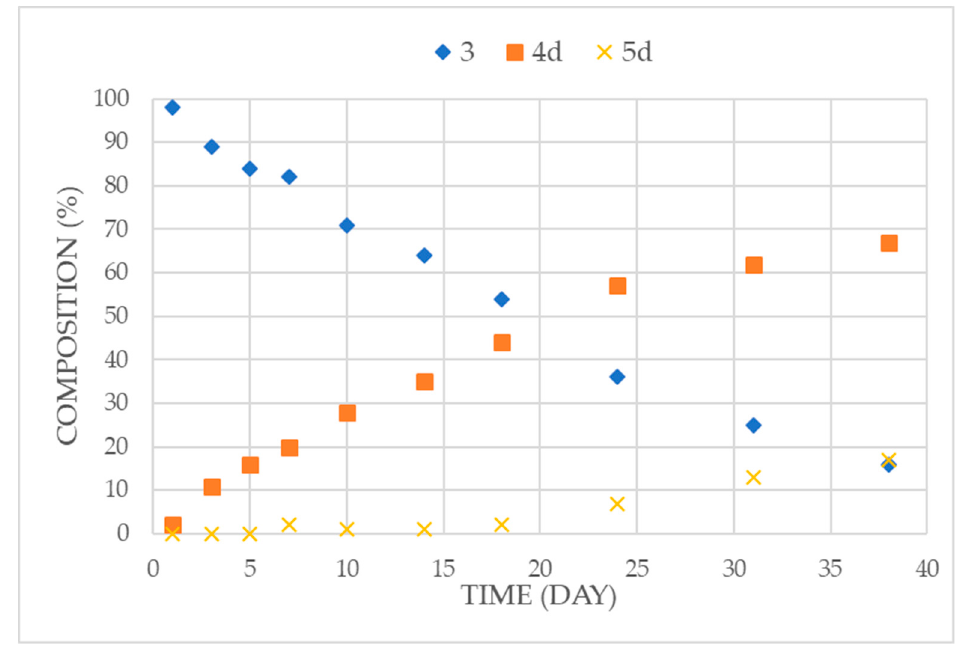
Figure 3. Alcoholysis of dibenzyl phosphite ( 3 ) with butanol at room temperature .